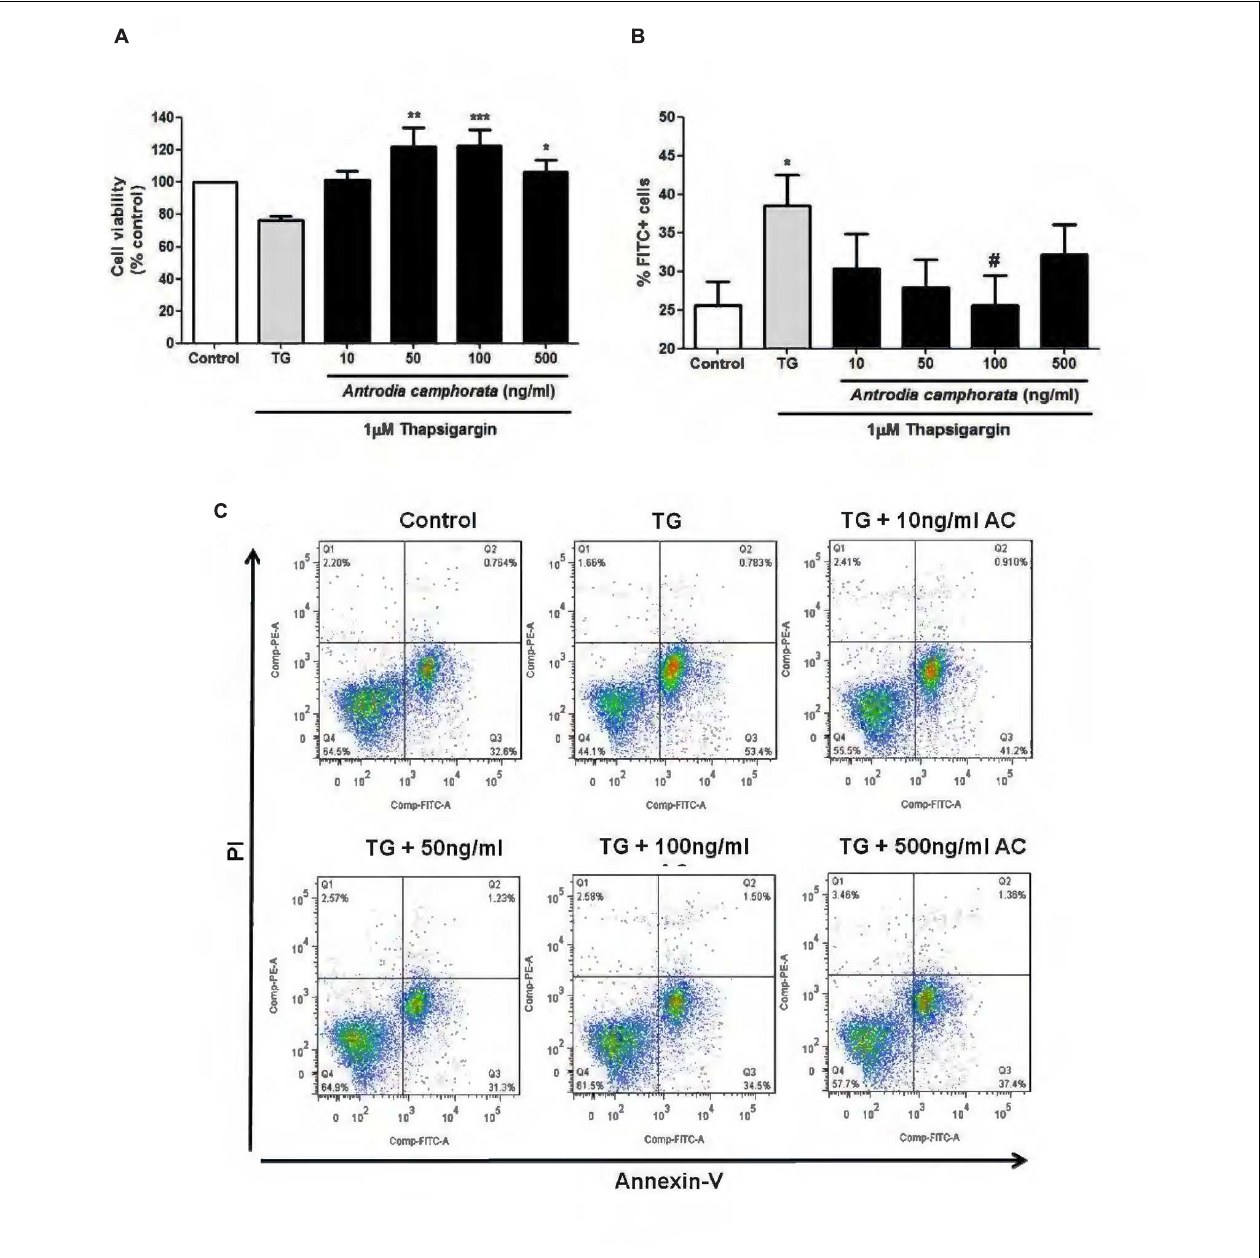
FIGURE 3 | Antrodia camphorata reduced ER stress-induced apoptosis in MIN6 cells. The cells were treated with A. camphorata (10–500 ng/ml) for 24 h and apoptosis was induced by 1 µ M TG for 24 h. (A) MTT assay was performed to measure the cell viability, n = 5. ∗ P < 0.05 , ∗∗ P < 0.01 , ∗∗∗ P < 0.001 vs. TG only. (B) Cell apoptosis was measured by Annexin V–PI staining using flow cytometry. Annexin V–fluorescein isothiocyanate (FITC) positive cells were defined as early apoptotic cells, n = 7. ∗ P < 0.05 vs. control; # P < 0.05 vs. TG. (C) Representative flow cytometric analyses for Annexin V–PI staining. Results were expressed as mean ±